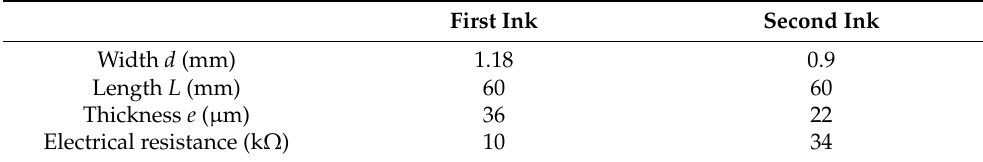
Table 3. Dimension and electrical measurements of the conductive